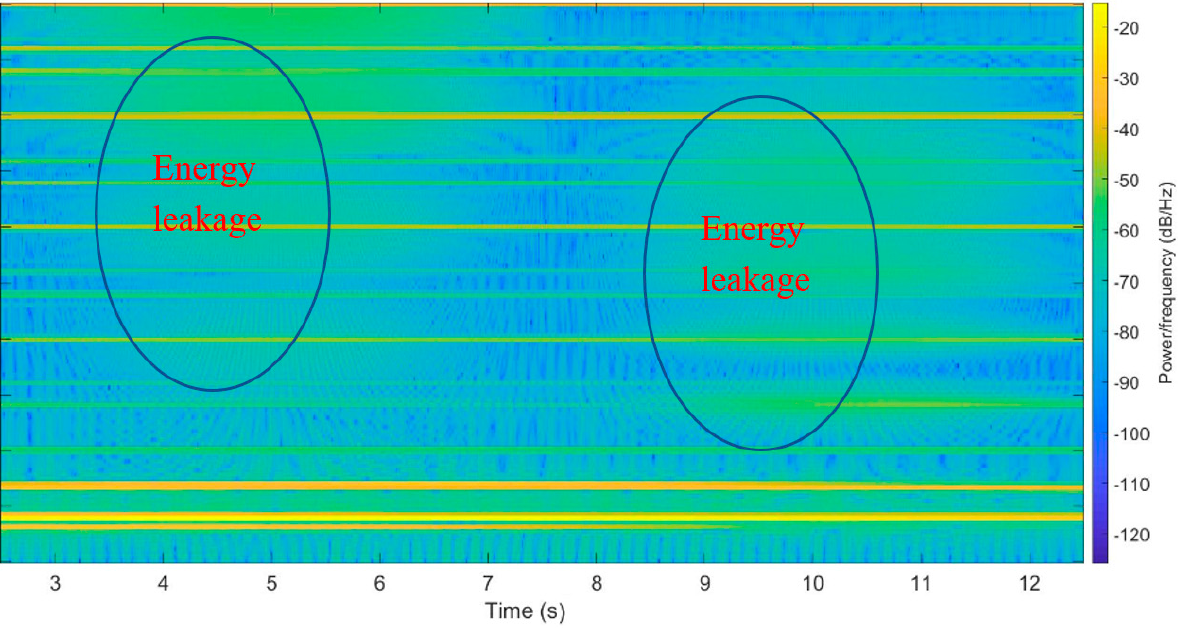
Figure 16. STFT result of the bridge deck with a 10 cm damage at 5 m through the drive-by front tire acceleration time history (Energy leaked